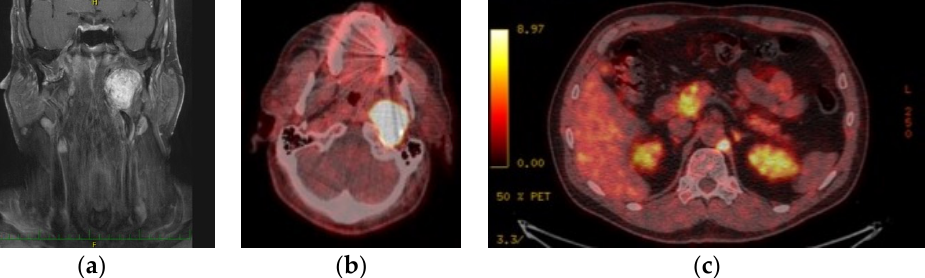
Figure 1. Vagal PGL on ( a ) MRI of the neck (coronal view) and ( b ) 18F-FDOPA PET-CT as well as ( c ) retroperitoneal PGL on 18F-FDOPA PET-CT seen in a patient with SDHB mutation. Carrier status of relatives were not determined since the family members did not consent to the